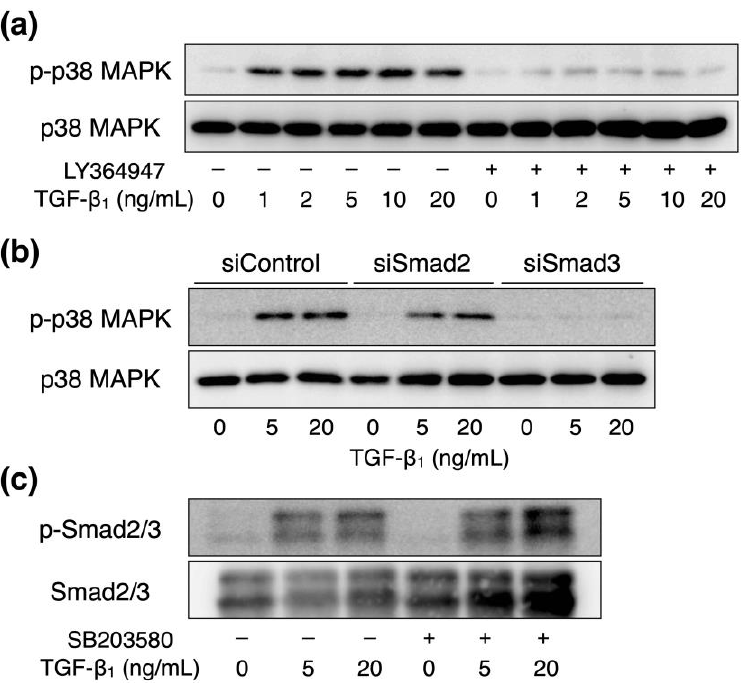
Figure 5. Interaction between TGF- β 1 -activated Smad2/3 and p38 MAPK signaling in vascular endothelial cells. ( a ) B ovine aortic endothelial cells treated with or without LY364947 (5 μM) for 24 h were treated with or without TGF- β 1 (1, 2, 5, 10, or 20 ng/mL) for 6 h, and the expression levels of phosphorylated p38 MAPK (p-p38 MAPK) and total p38 MAPK proteins were determined using Western blotting. ( b ) Bovine aortic endothelial cells transfected with control, Smad2, or Smad3 siRNAs for 24 h were treated with or without TGF- β 1 (5 or 20 ng/mL) for 6 h, and the expression levels of phosphorylated p38 MAPK (p-p38 MAPK) and total p38 MAPK proteins were determined using Western blotting. ( c ) Bovine aortic endothelial cells treated with or without SB203580 (10 μM) for 3 h that were treated with or without TGF- β 1 (5 or 20 ng/mL) for 1 h, and the expression levels of phosphorylated Smad2/3 (p-Smad2/3) and total Smad2/3 proteins were determined using Western blotting.